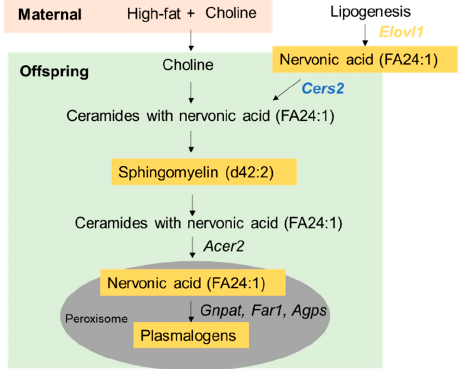
Figure 7. Potential mechanism by which maternal high-fat feeding and choline supplementation increase offspring hepatic plasmalogen abundance. Yellow highlight: increased abundance; blue highlight: decreased abundance by maternal high-fat plus choline supplementation in the current study. Acer2 , alkaline ceramidase 2; Agps , alkylglycerone phosphate synthase; Cers2 , ceramide synthase 2; Elovl1 , elongation of very long chain fatty acid; FA, fatty acid; Far1 , fatty acyl-CoA reductase 1; Gnpat , glyceronephosphate O-acyltransferase.